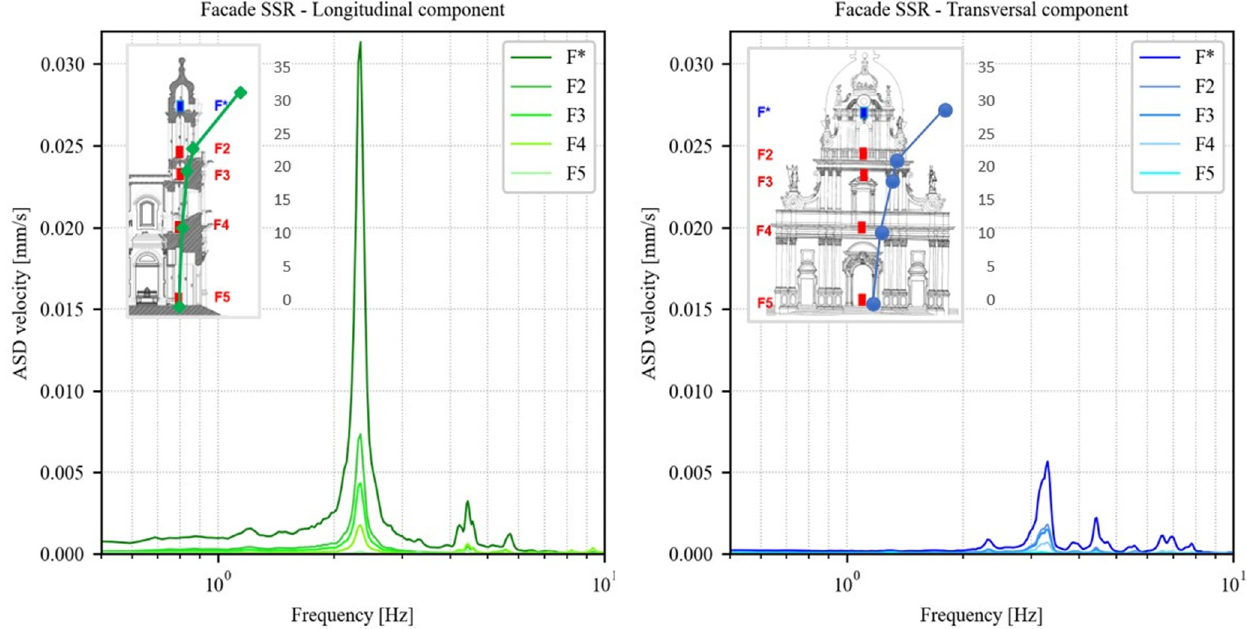
Figure 15. SSR analysis of the façade in longitudinal and transversal direction at Master F* and Rovers F2, F3, F4, F5 locations, with identification of modes f1 at 2.34 Hz (above) and f2 at 3.34 Hz (below), and the related mode shapes obtained by FDD.